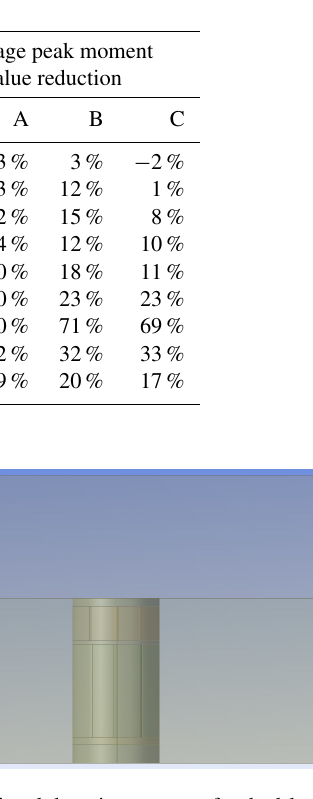
Figure 8. Computational domain geometry for dual-level